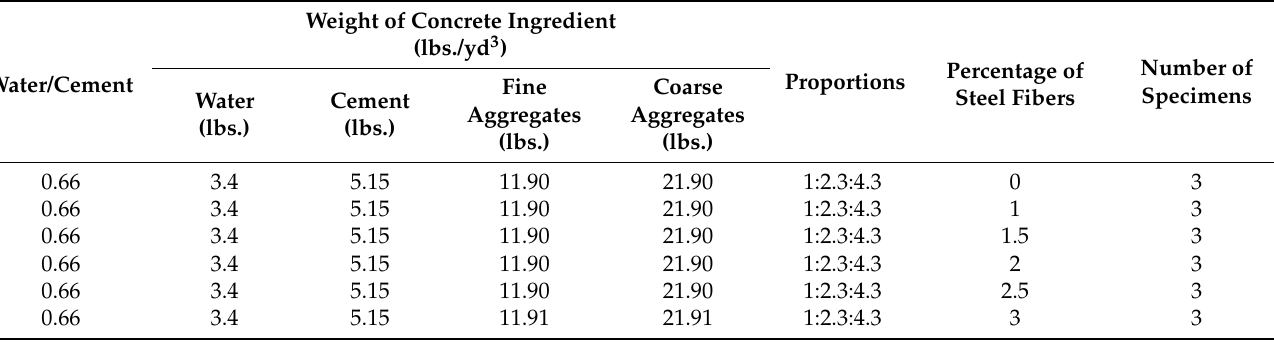
Table 4. Mix design/proportion